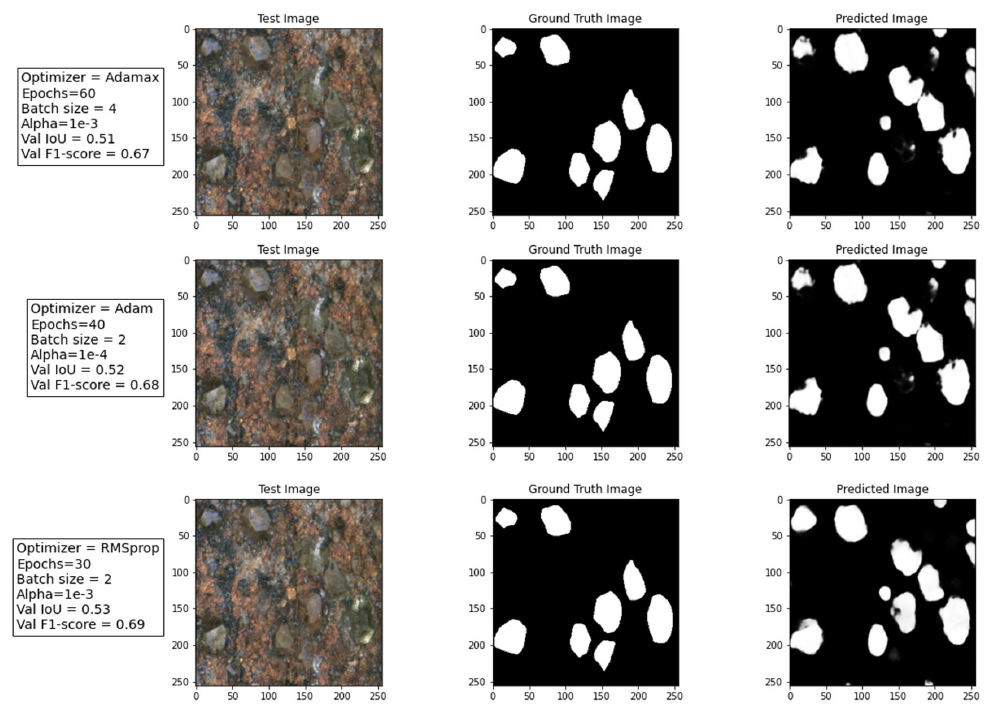
Figure 7 . DGW test images of type I, associated mask and prediction for each optimizer. Figure 7. DGW test images of type I, associated mask and prediction for each optimizer.